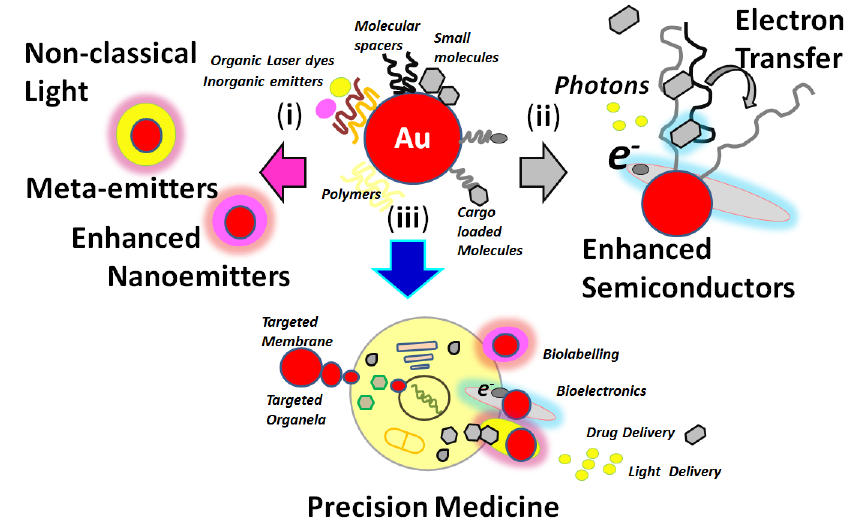
Figure 1. Representation of gold nanoplatforms chemical modifications and targeted studies and applications focused on: (i) nanophotonics; (ii) nanoelectronics; and (iii) nanomedicine. Reprinted with permission from ref. [10].